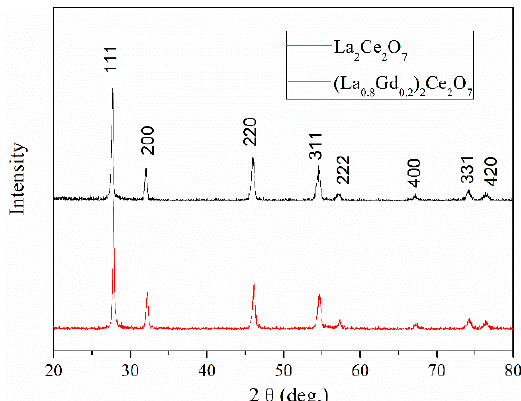
Figure 7. XRD patterns of as-fabricated double-ceramic-layer (DCL) thermal barrier coatings (TBCs).